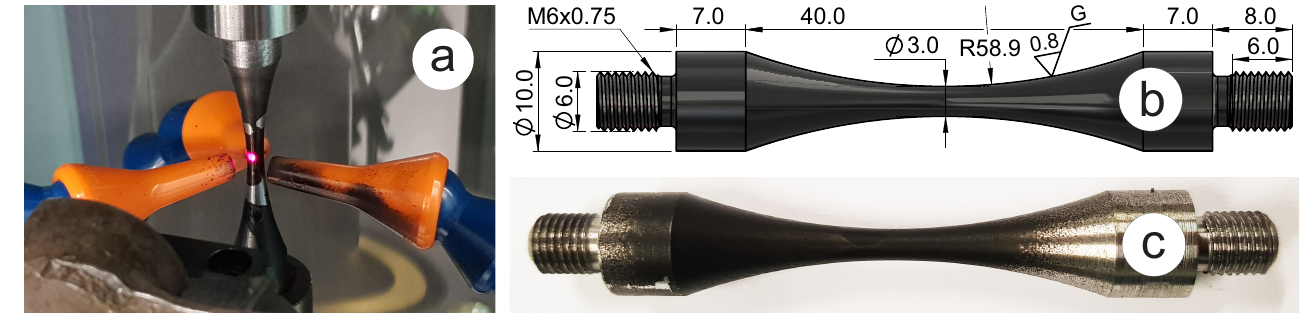
Figure 3. Specimen for ultrasonic test: ( a ) inserted in UFS-2000A with temperature measurement spot; ( b ) solid model with dimensions; ( c ) machined and painted